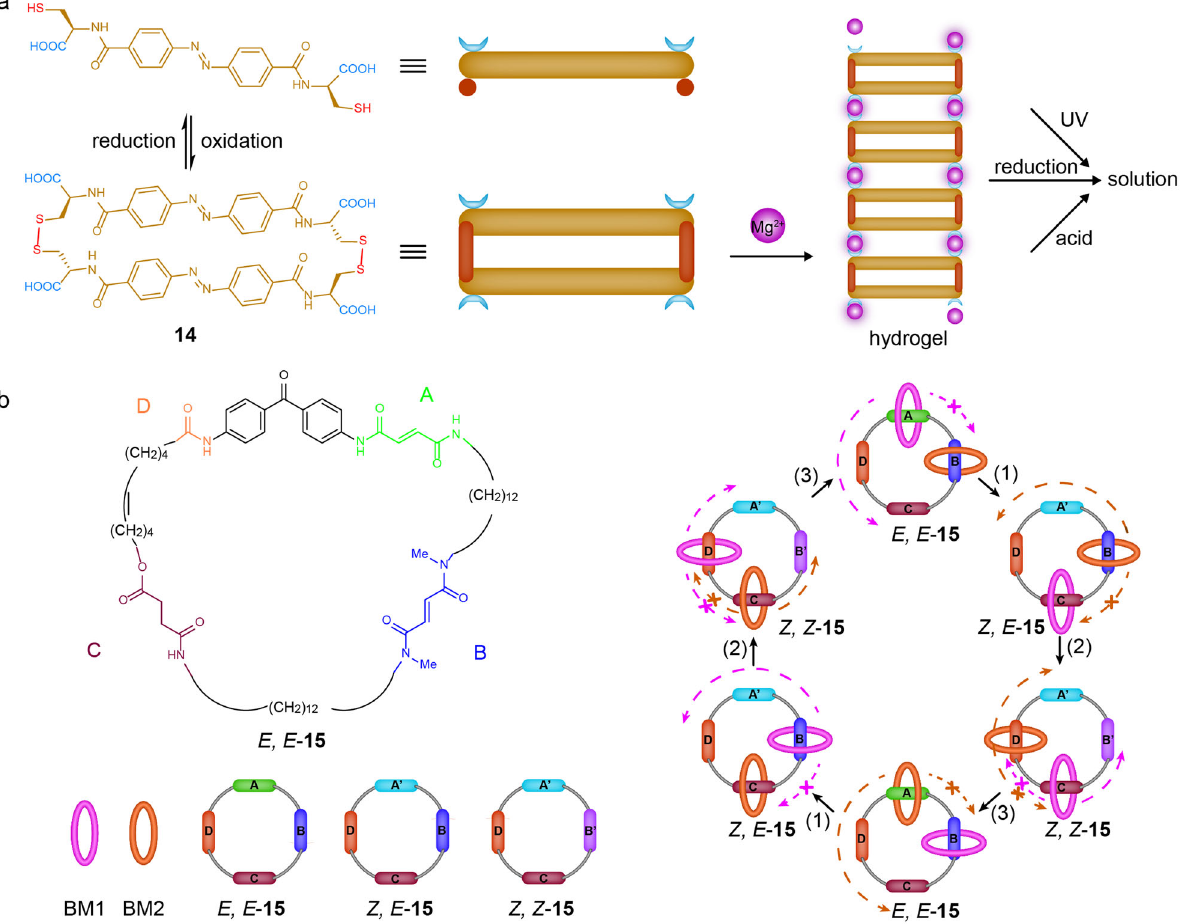
Fig. 4 Multistimulus-responsive macrocycles. a the multistimulus-responsive sol-gel process of the hydrogel formed by the macrocycle 14 and Mg 2 + , 44 . b the chemical structure of macrocycle 15 containing four distinguishable recognition sites and the unidirectional rotation of two benzylic macrocycles (BM1 and BM2) along the track of the 15 in the [3]catenane controlled by alternate light irradiation and heating cycles: (1) 350 nm, 5 min, (2) 254 nm, 20 min and (3) 100 °C, 24 h 45